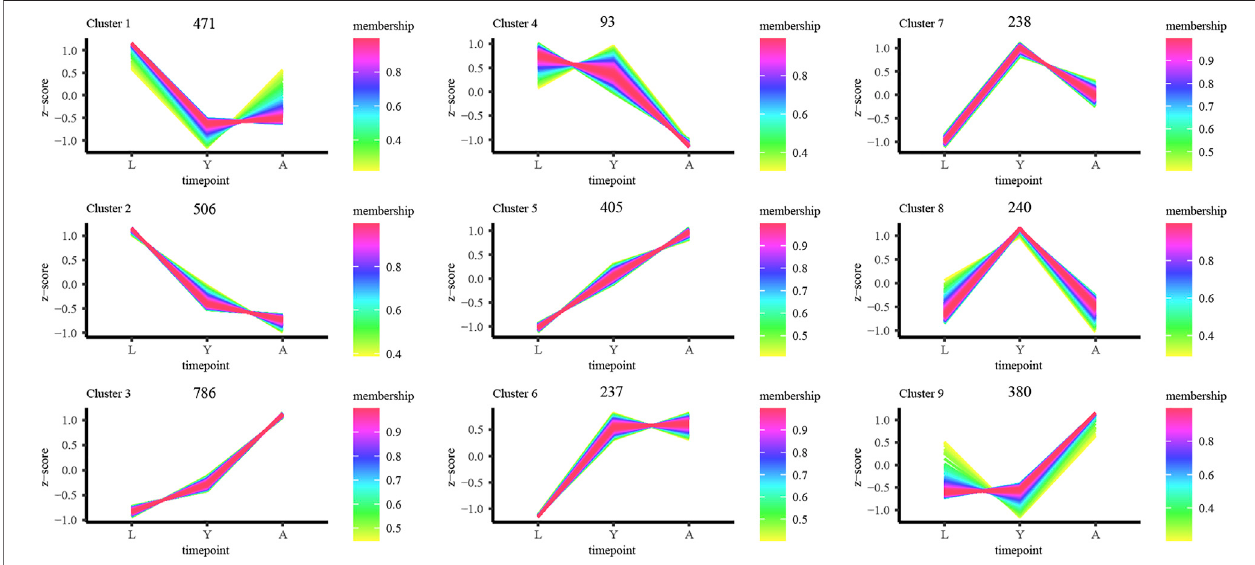
FIGURE 4 | Sample time-series analysis of DEGs. The horizontal axis represents different growth periods, and the vertical axis represents normalized gene expression.